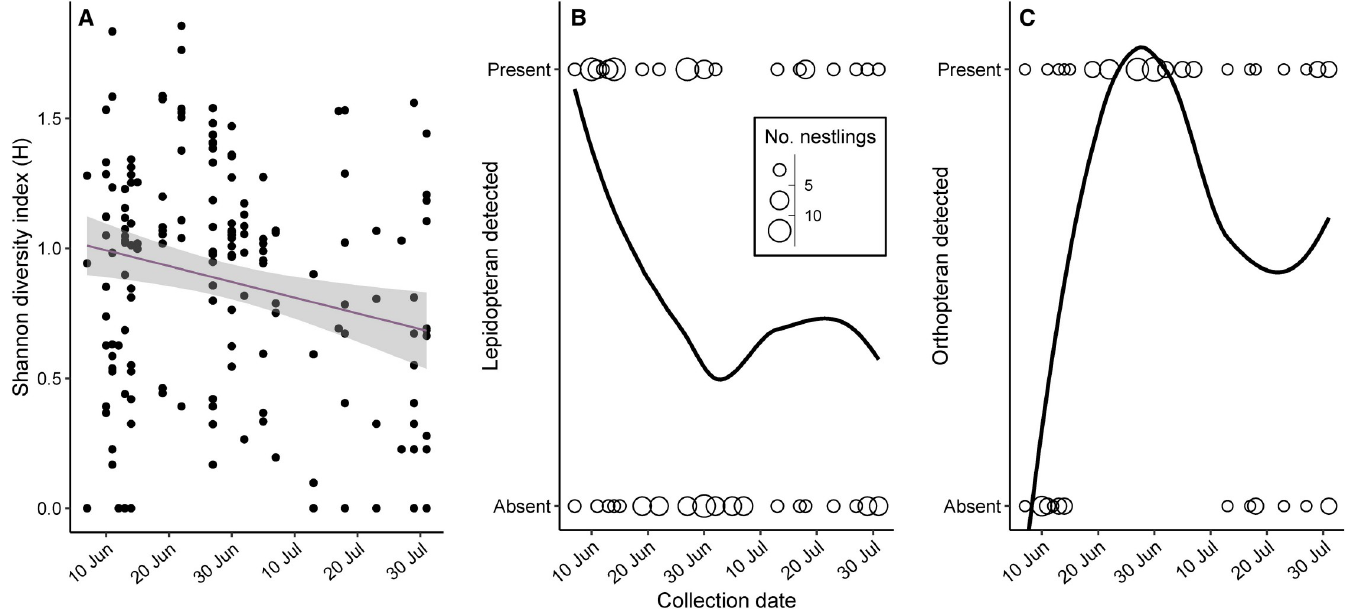
Fig 3. Nestling diet diversity and the presence of common prey items changed over time. The diversity of prey (H) in nestling diets decreased with date (A). Lepidopterans were present in nestling diets early (June), but declined over time (B), whereas Orthoptera were absent from nestling diets early, peaked around the same time that lepidopterans declined, then leveled out later (circle size is proportional to the number of individual nestlings with and without Lepidoptera (B) and Orthoptera (C) detected in their diet).